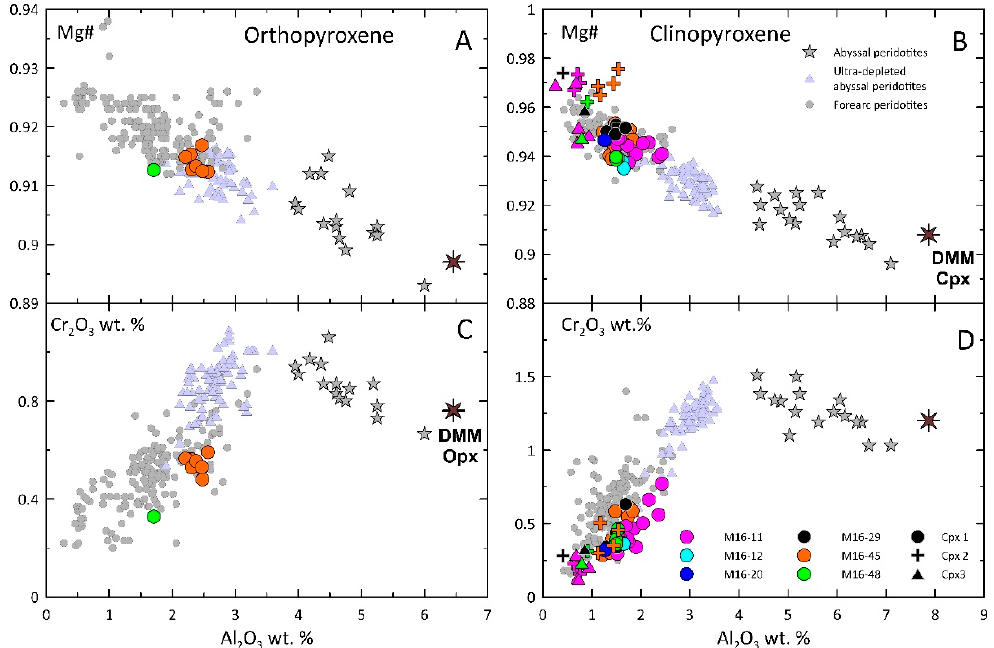
Figure 4. Major-element compositions of orthopyroxene ( A , C ) and clinopyroxene ( B , D ) from the Alag Khadny peridotites. Cpx1—interstitial clinopyroxene, Cpx2—metamorphic clinopyroxene in pseudomorphs after orthopyroxene, Cpx3—metamorphic clinopyroxene from serpentine veinlets after olivine. Different colors of the symbols are referred to different samples as shown in ( D ). Clinopyroxene and orthopyroxene compositions of Depleted MORB Mantle (DMM) are from [46], clinopyroxene analyses for the abyssal peridotites [47,48], ultra-depleted abyssal peridotites [39], and forearc peridotites [49] are shown for comparison.